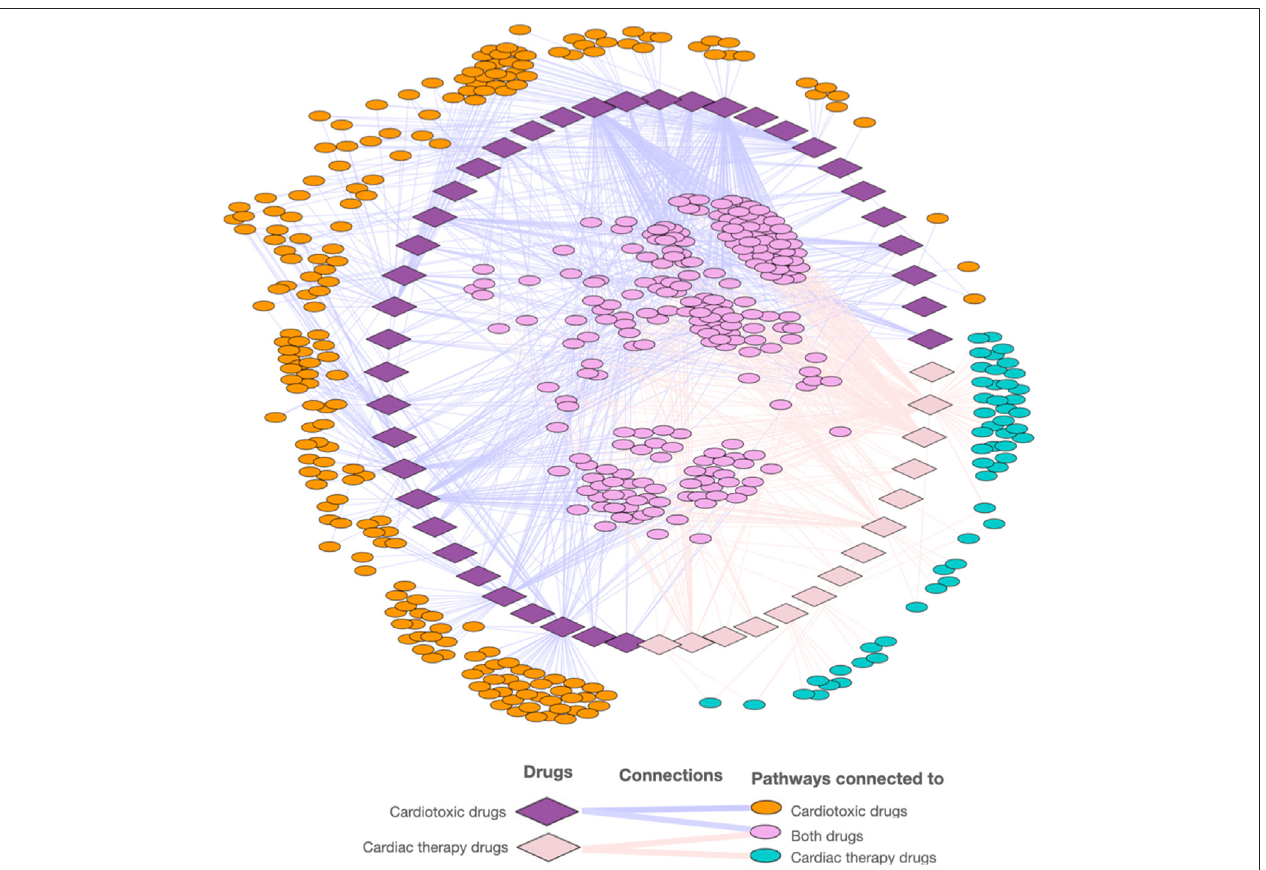
FIGURE 4 | Visualization of the network of cardiotoxic and cardiac therapy compounds and associated pathways.